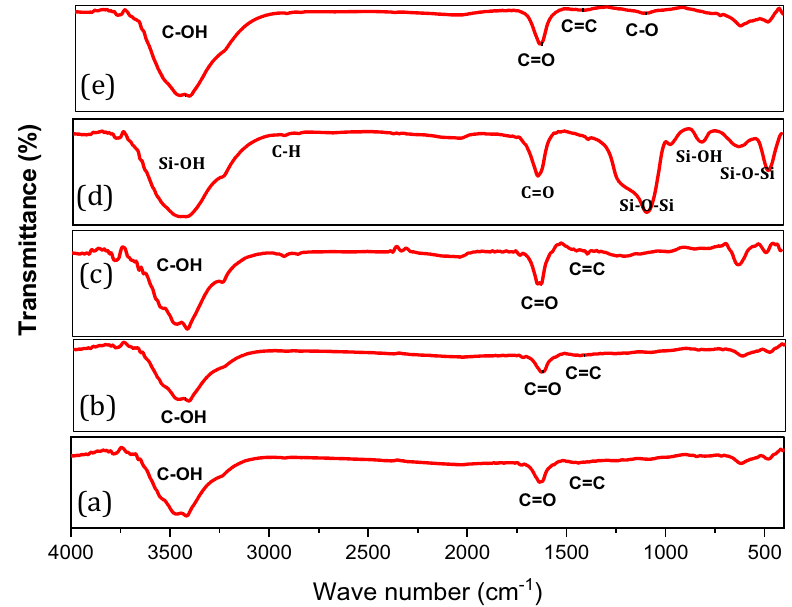
Figure 7: FT - IR: ( a ) FCNT1, ( b ) CNT1, ( c ) CNT3, ( d ) SBA - 15, ( e )